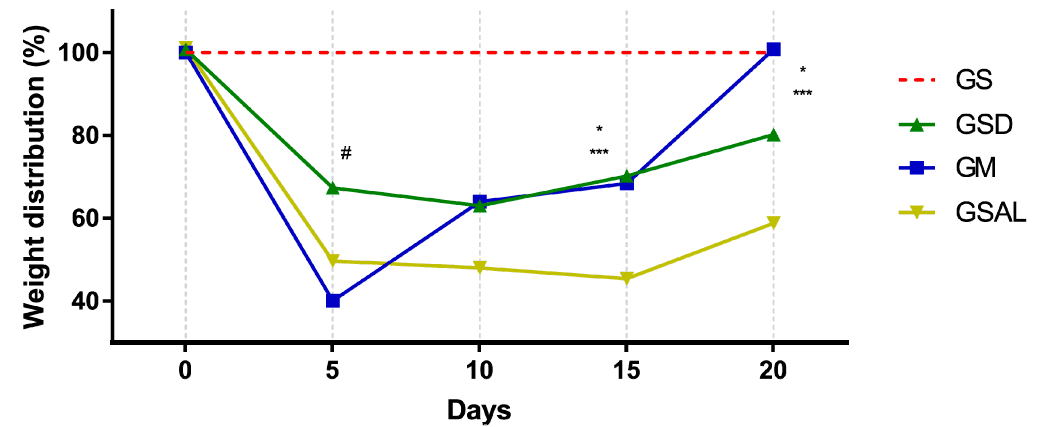
Figure 3. Effect of the crude extract of S. dulcis on the assessment of the weight distribution in the hind paws using the weight bearing test. Results were expressed as mean ± standard mean error; # difference between GS and GSAL in D5 ( p ˂ 0.0001), GS and GSD in D5 ( p ˂ 0.0001) and GS and GM in D5 ( p ˂ 0.0001); * difference between GSD and GSAL in D15 ( p = 0.0025) and D20 ( p = 0.0037); *** difference between GM and GSAL in D15 ( p = 0.0062) and D20 ( p ˂ 0.0001), using 2-way ANOVA with the multiple comparisons test ( p < 0.05).